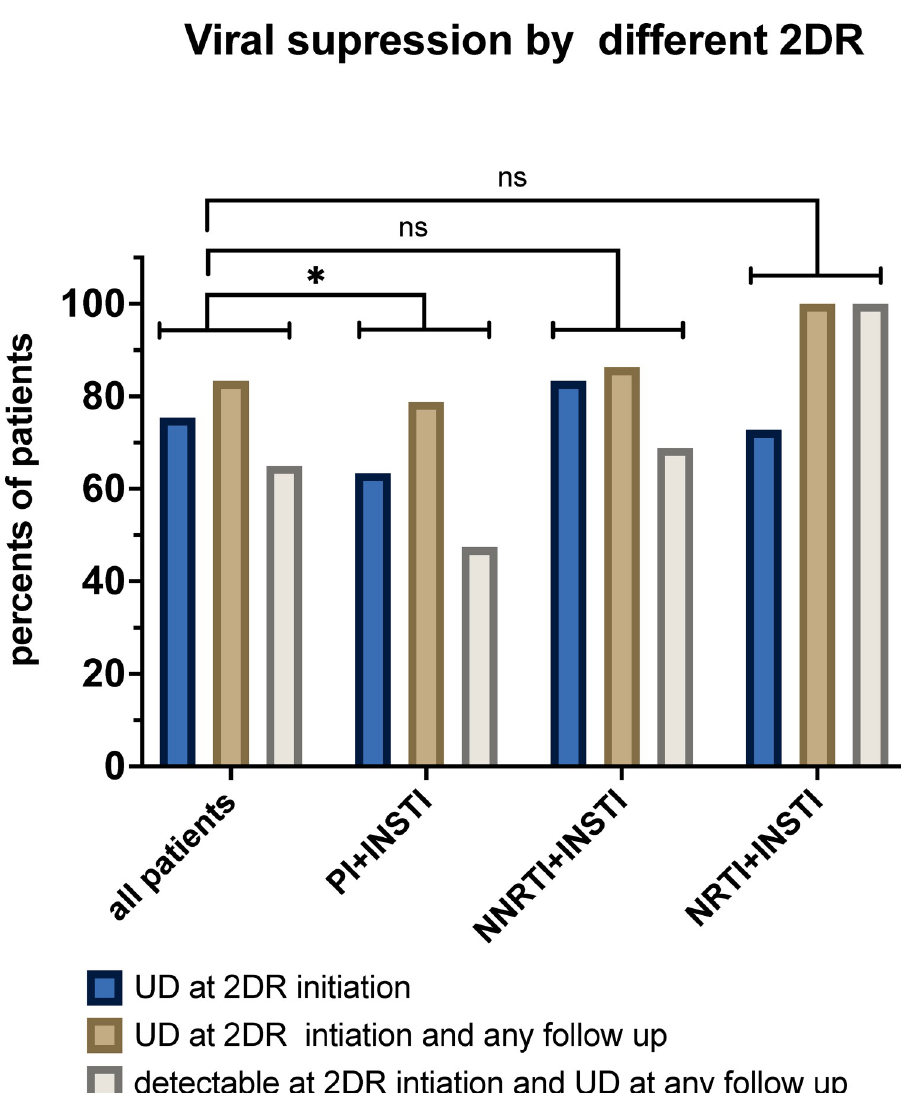
Fig 4. Viral suppression by different 2DR by class. UD at 2DR initiation- percent of total patients that started each 2DR combination. UD at 2DR initiation and at any follow up- percent of patients that started 2DR with undetectable viral load and were suppressed in every test- week 24, 48 96 and 144. Detectable at 2DR initiation and UD at any follow up- percent of patients that started with detectable viral load but later were suppressed in every test at week 24, 48 96 and 144. Patients that were changed to 2DR that was composed of PI and INSTI had lower rates of suppressed viral load and higher rates of failure in comparison to patients in other 2DR. p < 0.05 McNemar test.